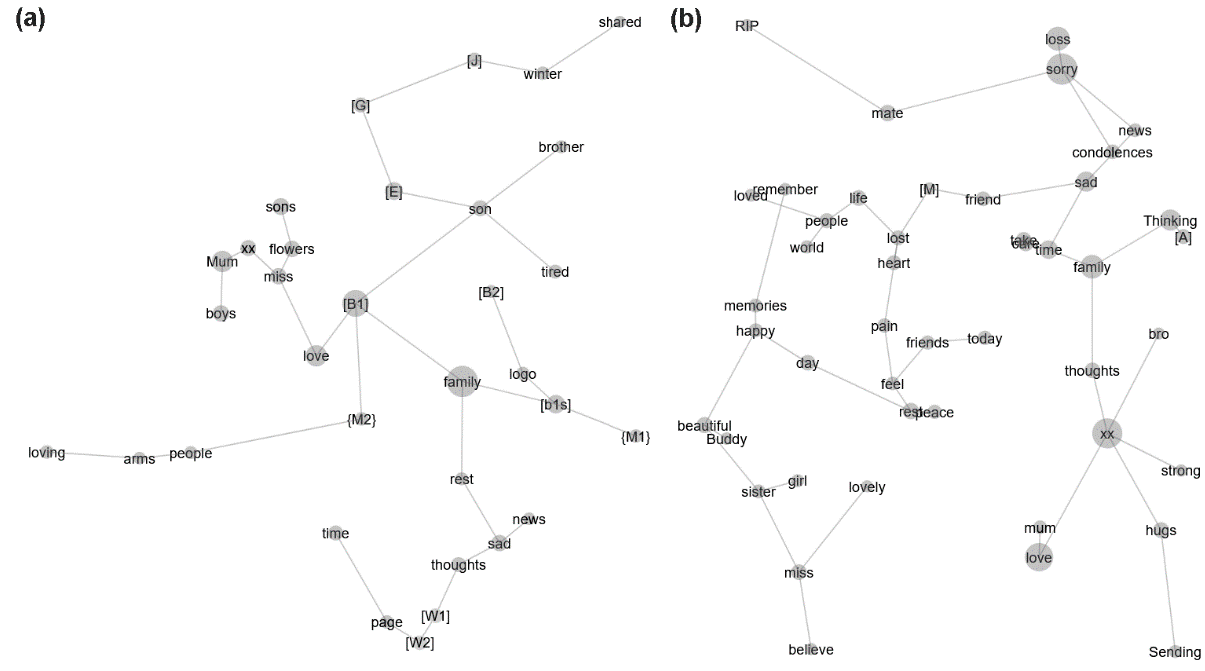
Figure 1. Leximancer concept map for ( a ) the cluster cases and ( b ) the non-cluster